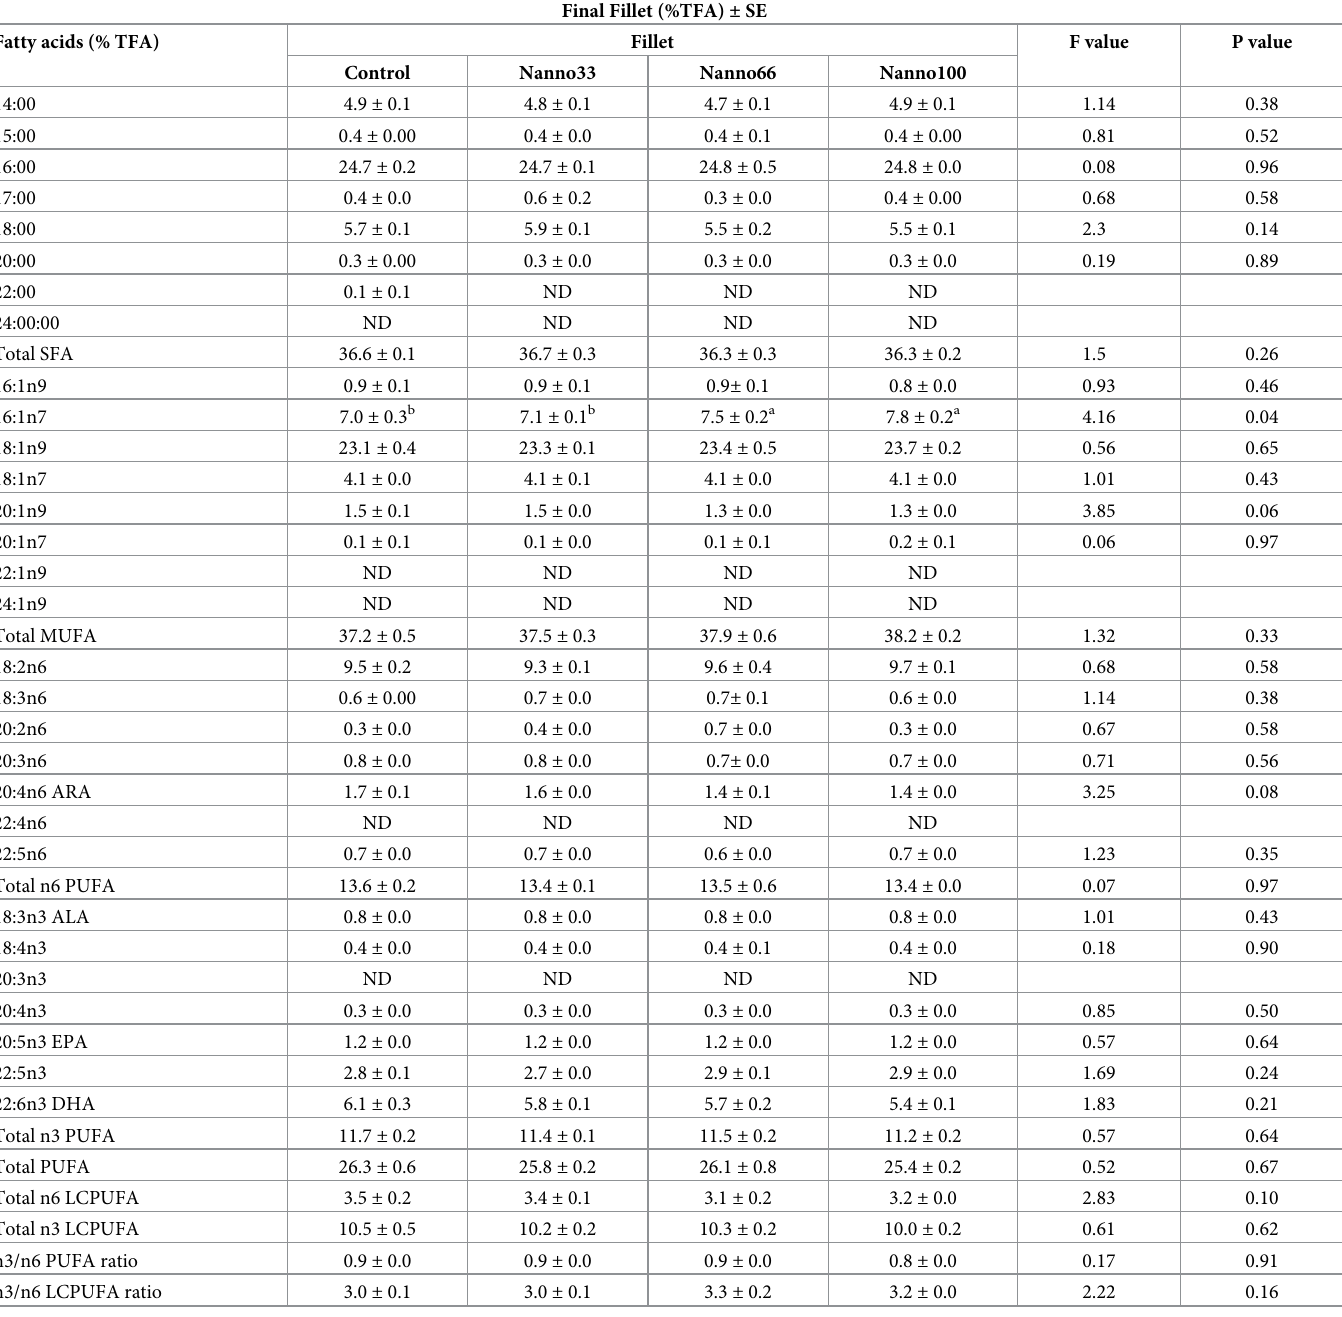
Table 13. Fatty acid (% of total fatty acids) content of fillets from Nile tilapia after 84 days on the experimental diets; average ± SE for 3 replicates per diet (pooled whole tissues of 5 fish/replicate)§. Fatty acids (%